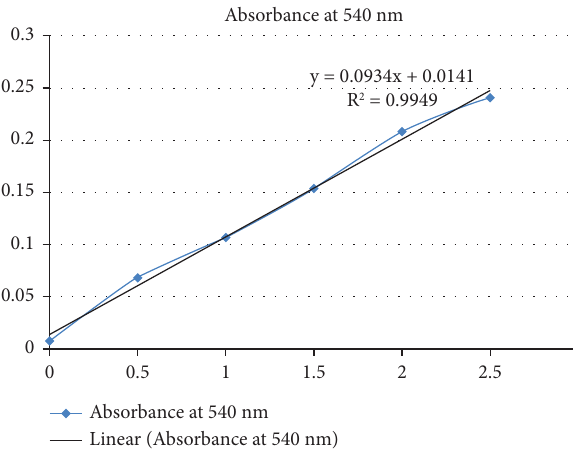
Figure 6: Standard curve to determine the concentration of unknown